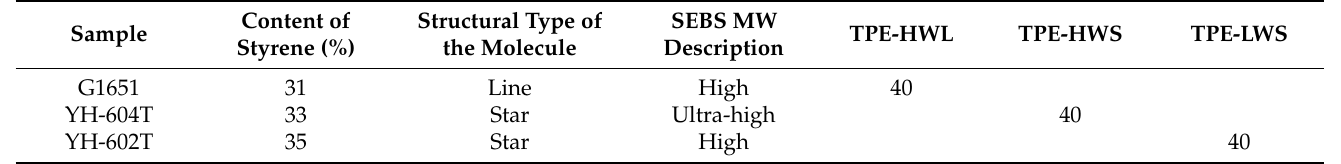
Table 8. Formula design of TPE prepared by SEBS with various molecular chain